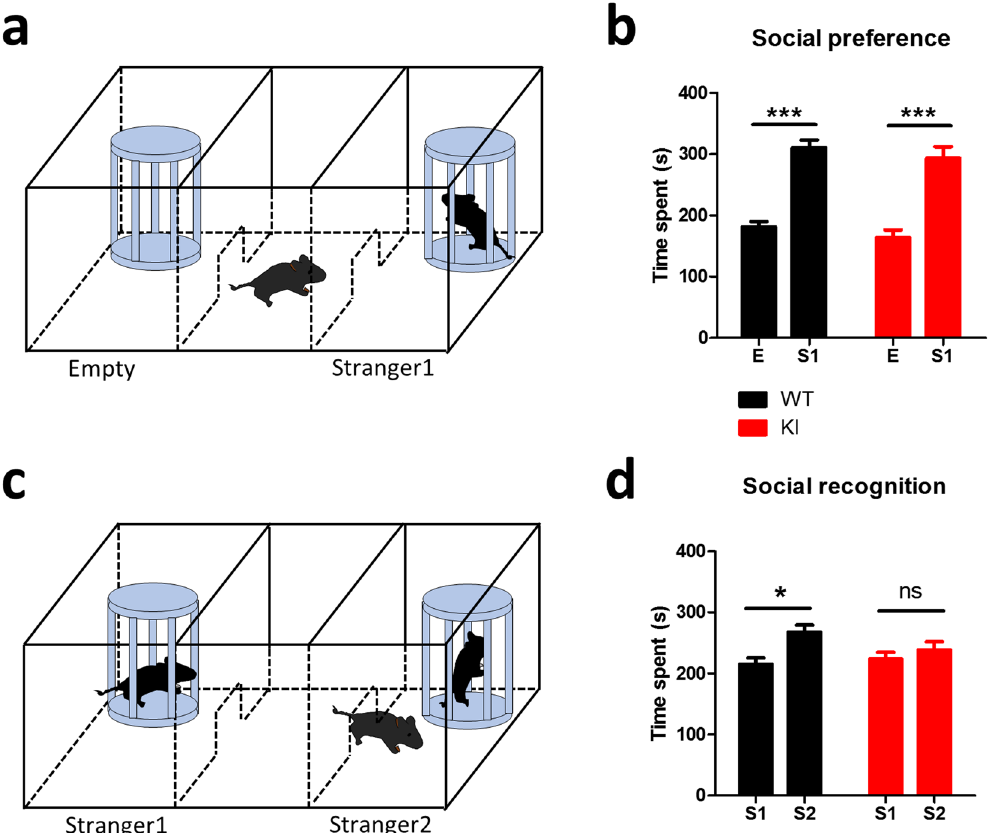
Figure 3. Lsd1 KI mice show impaired social recognition memory. ( a ) Experimental design for three-chamber test to measure sociability. ( b ) Exploration time for the empty cup (E) and the cup with stranger mouse (S1) of WT and Lsd1 KI mouse (WT: n = 13, KI: n = 11; two-way ANOVA, genotype x condition, F 1,44 = 0.00, p = 1.000, effect of genotype, F 1,44 = 1.78, p = 0.189, effect of condition, F 1,44 = 58.21, p < 0.0001; Bonferroni posttests, S1 vs E *** p < 0.0001). ( c ) Experimental design for three-chamber test measuring social recognition memory. ( d ) Exploration time for the cup with the familiar mouse (S1) and the cup with the stranger mouse (S2) of WT and Lsd1 KI mouse (WT: n = 13, KI: n = 11; two-way ANOVA, genotype x condition, F 1,44 = 2.59, p = 0.115, effect of genotype, F 1,22 = 0.79, p = 0.231; effect of condition, F 1,44 = 8.08, p < 0.01; Bonferroni posttests, S2 vs S1 * p < 0.05, ns: not significant). All graphs were plotted as mean ±